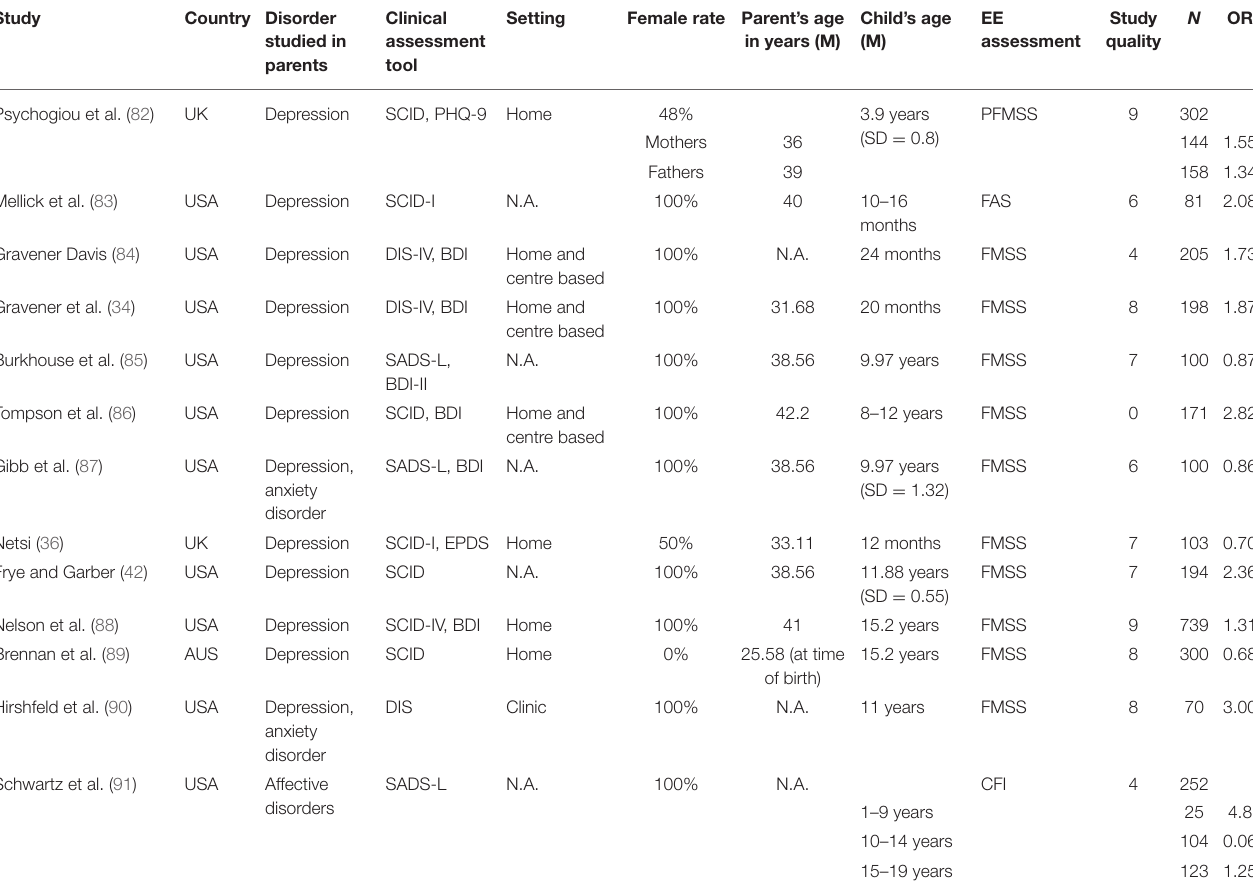
TABLE 2 | Studies included for meta-analysis with the dependent variable parental EE.